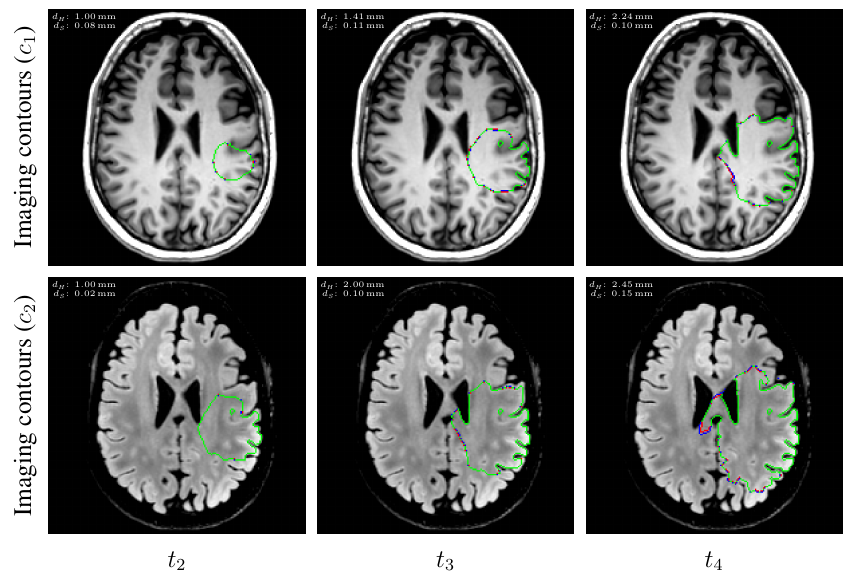
Figure A1. Example of true (1st row) and estimated (2nd row) three-dimensional tumor cell-density distributions at times t 2 − 4 (1st to 3rd column, axial slices) along with the corresponding absolute error maps (3rd row) for a test tumor ( d = 46.20mm 2 year − 1 , ρ = 12.92year − 1 , t 1 = 130d, t 2 = 268d). The imaging contours for threshold values c 1 = 0.80 and c 2 = 0.16 superimposed to the T1 and T2 FLAIR image are depicted in the 4th and 5th rows, respectively. The blue, red, and green segments respectively correspond to the target, prediction, and overlapping contour voxels. MAE: mean absolute error for c > 0.01, d H : Hausdorff distance, d S : average symmetric surface distance.